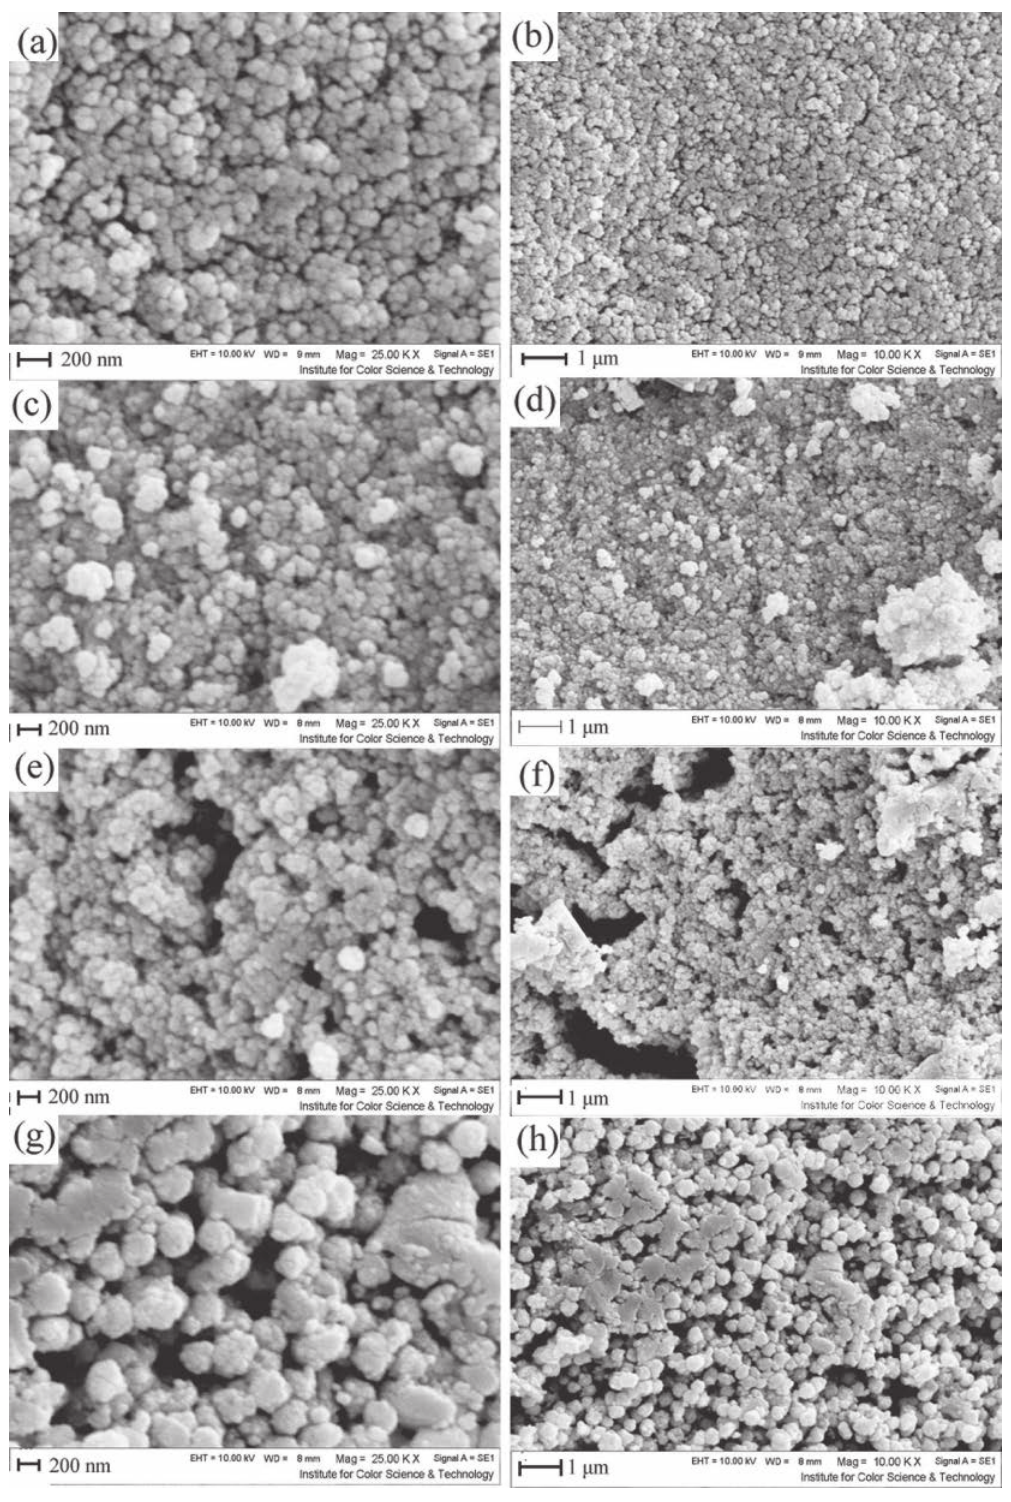
Fig. 4: SEM images of the surfactant effect: (a), (b) sample no. 2; (c), (d) sample no. 3; (e), (f) sample no. 4 and (g), (h) sample no.